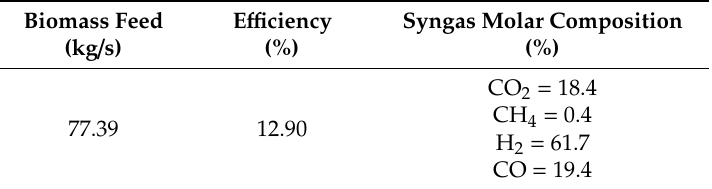
Table 6. Hydrogen production results based on biomass gasification